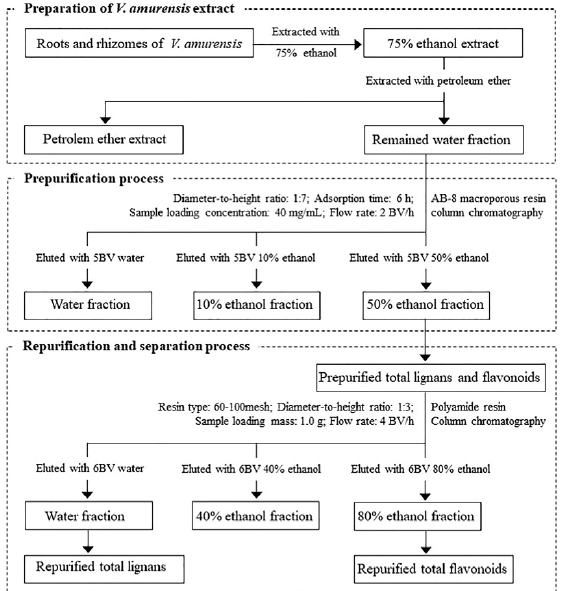
Figure 8. Process optimization on purification and separation of lignans and flavonoids from V. amurensis .